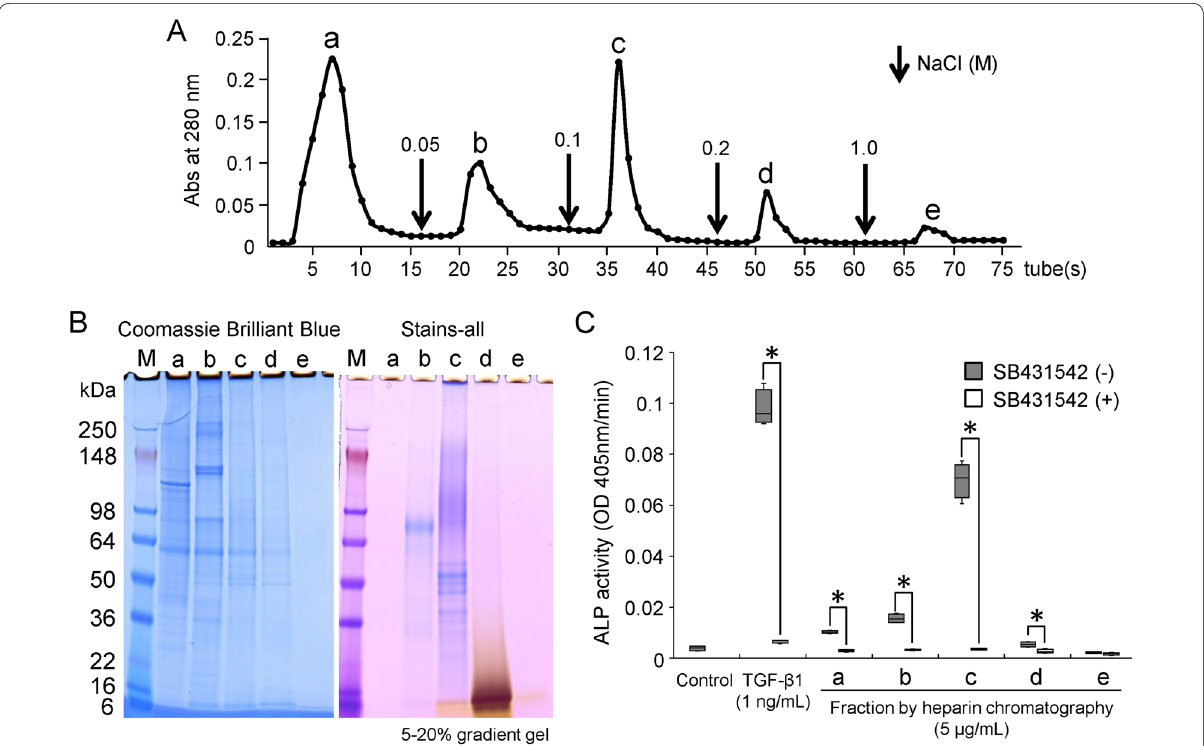
Fig. 4 Isolation of NCPs coexisting with TGF‑β in the G2 extract. A Heparin affinity chromatogram showing absorbance at 280 nm for the G2 extract obtained from bone powder of rat tibiae and femora (50 mg). Downward‑pointing arrows are the starting point of the step gradient with 0.05, 0.1, 0.2 and 1 M NaCl. B SDS–PAGE (5–20% gradient gel) stained with Bio‑Safe Coomassie Brilliant Blue (Coomassie Brilliant Blue, left) and Stains‑all (right) showing fractions a , b , c , d , and e on a heparin affinity chromatogram. C ALP‑inducing activity of HPDL cells exposed to fractions a , b , c , d , and e (5 μg/mL each) and CF‑hTGF‑β1 (1 ng/mL) without ( ) or with ( ) SB431542. Data in box indicate the 25‑75% tiles of IQR, and the end of whiskers − + indicates maximum and minimum values, respectively. The median is represented as line located in the middle of box (* p < 0.05, Mann–Whitney U